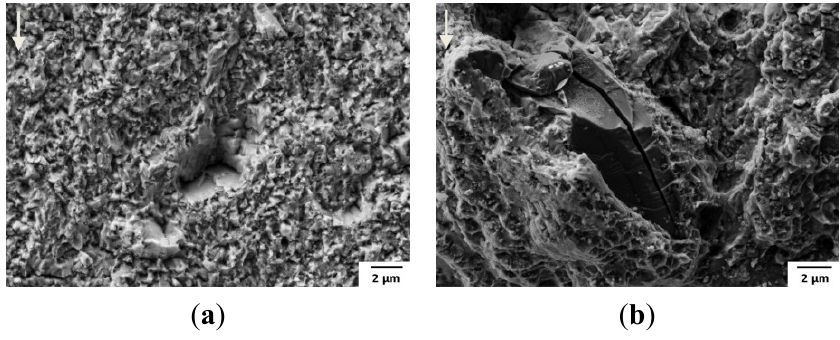
Figure 6. Fatigue crack surfaces of the reinforced conditions: ( a ) non-ECAP-processed and ( b ) after one ECAP pass near the fatigue threshold. The crack propagation direction is marked with an arrow. The surface is less rough and barely fissured as compared to the unreinforced conditions. Through additional ECAP, the particle failure is more likely to fracture than to break